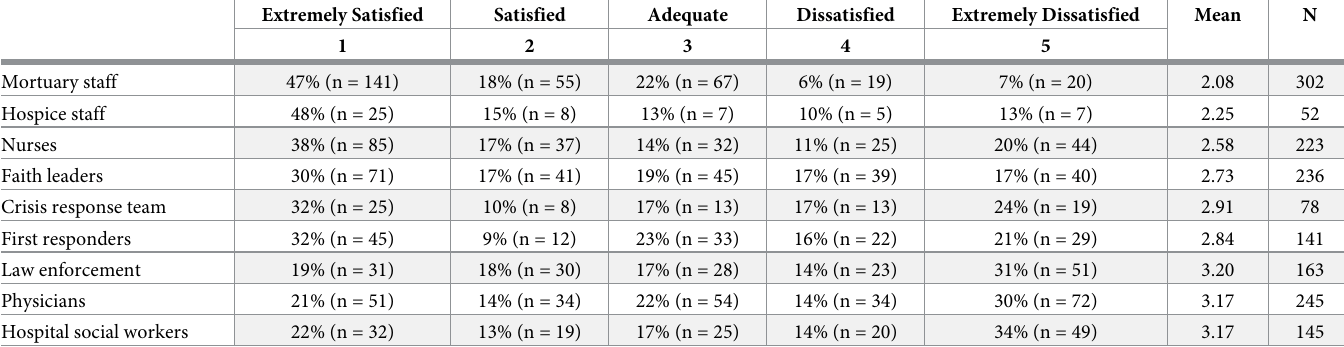
Table 1. Satisfaction with crisis support in